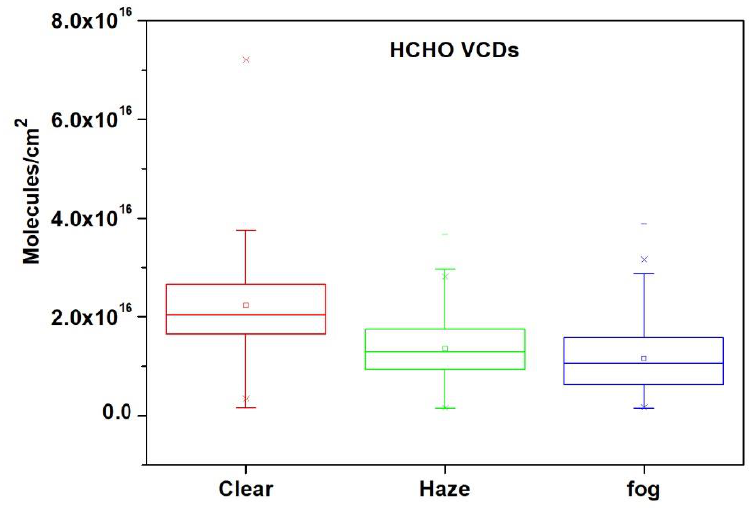
Figure 9. Boxplot for HCHO VCDs during different conditions.